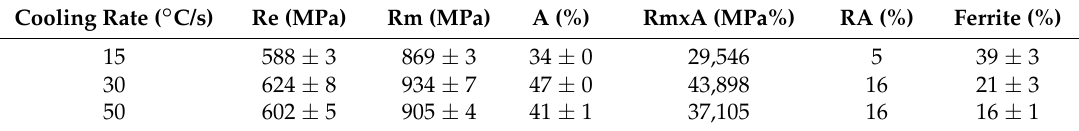
Table 3. Effect of cooling rate on tensile strength, total elongation, formability factor, retained austenite volume fraction, and polygonal ferrite fraction. Samples soaked at 850 ◦ C/100 s with bainitic hold 400 ◦ C/600 s.